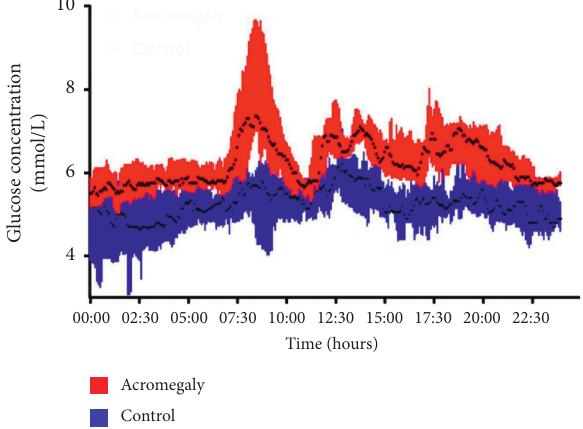
Figure 3: The 24-hour glucose profile of two groups. Data are medians (25 th –75 th